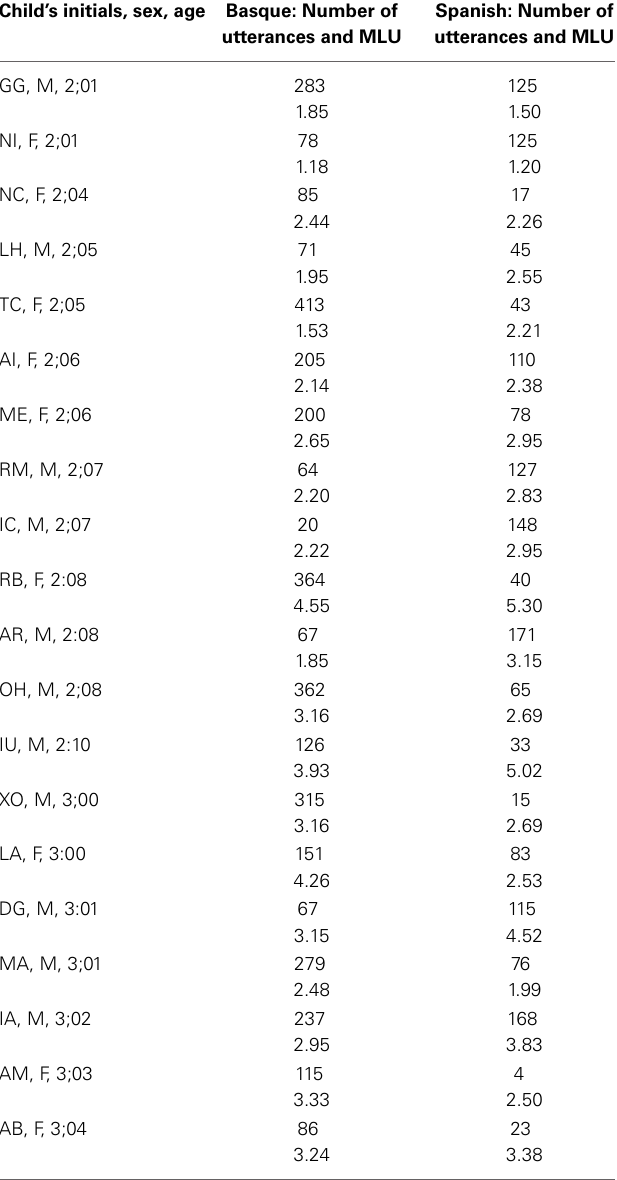
Table 3 | Number of utterances and MLU in each language for bilingual children.